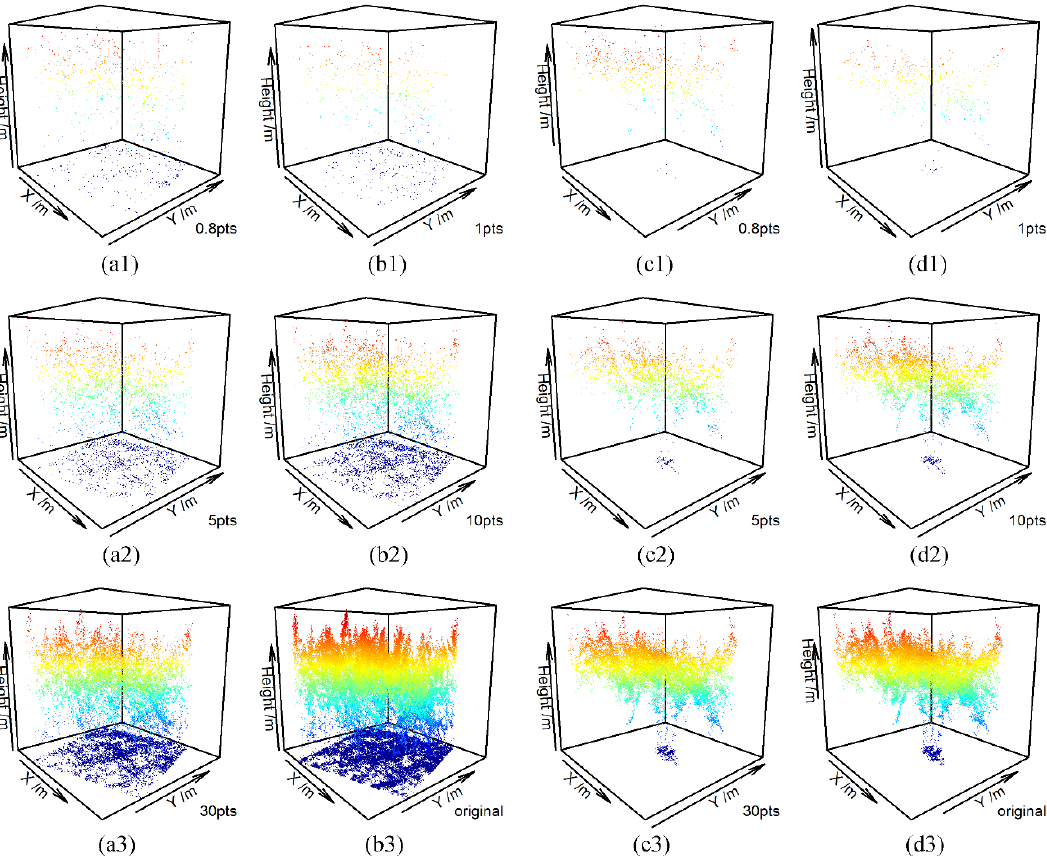
Figure 4. An example of thinned datasets with 0.8, 1, 5, 10, and 30 pts/m 2 and original data from ULS ( a1 – a3 , b1 – b3 ) and USP ( c1 – c3 , d1 – d3 ) at plot